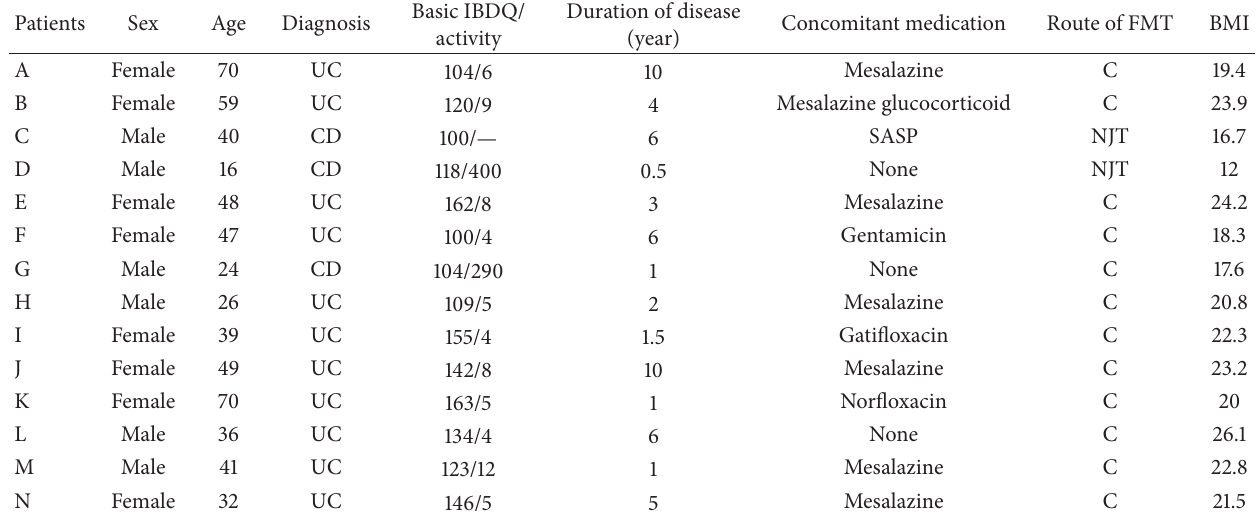
Table 1: Basic characteristics of